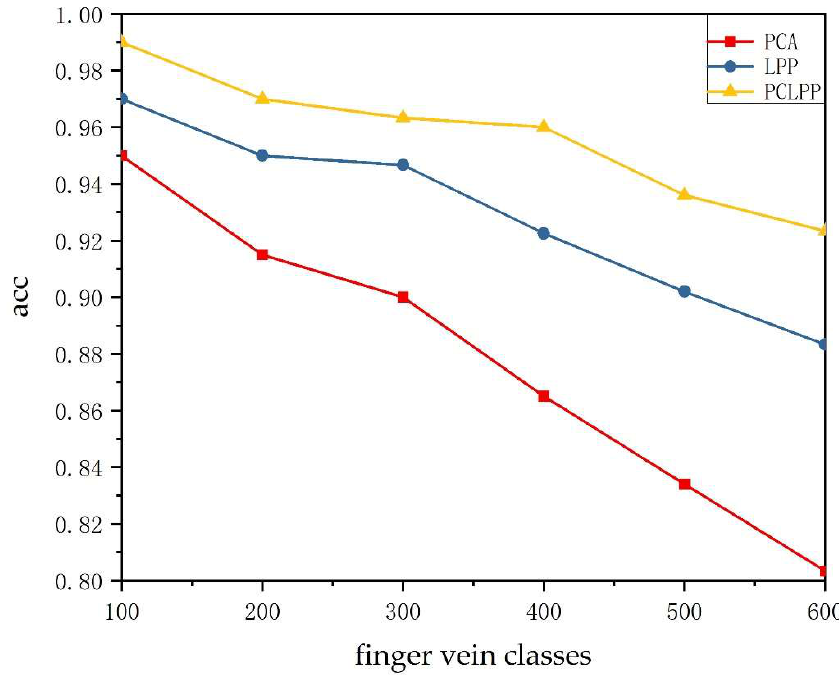
Figure 5. Finger vein recognition rates for PCA, LPP, and PCLPP with different numbers of catego- ries.